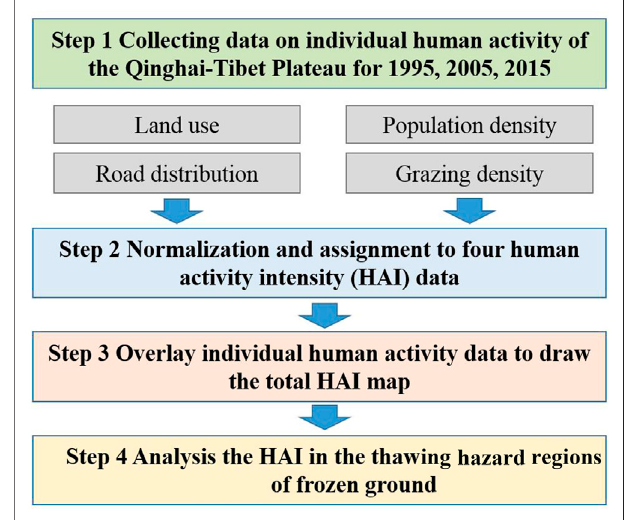
FIGURE 2 | The work fl ow of this